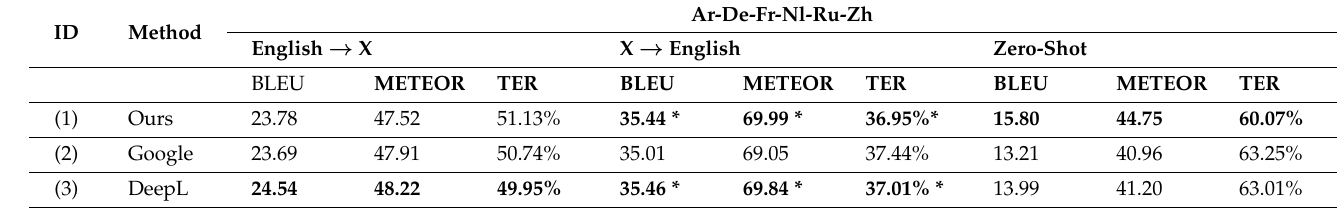
Table 8. The BLEU, METEOR and TER scores of different systems in the OPUS-100 test sets. The best results, indicated in bold, are statistically significant against all other results, for p < 0.05, except where indicated as *; differences between top-performing systems in bold were not statistically